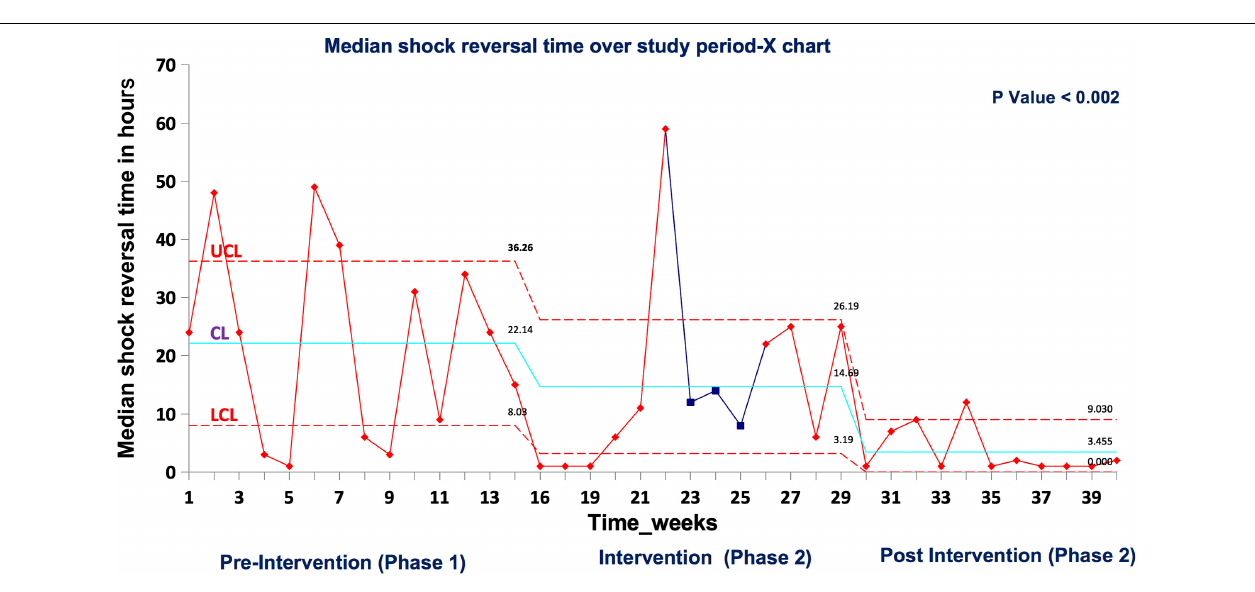
was reduced from 24 h (pre) to 6 h (during), and to 4.5 h (post), p < 0.002 for pre vs. post ( Figure 11 ). These findings of clinical outcomes in real patients with shock are summarized in Table 3